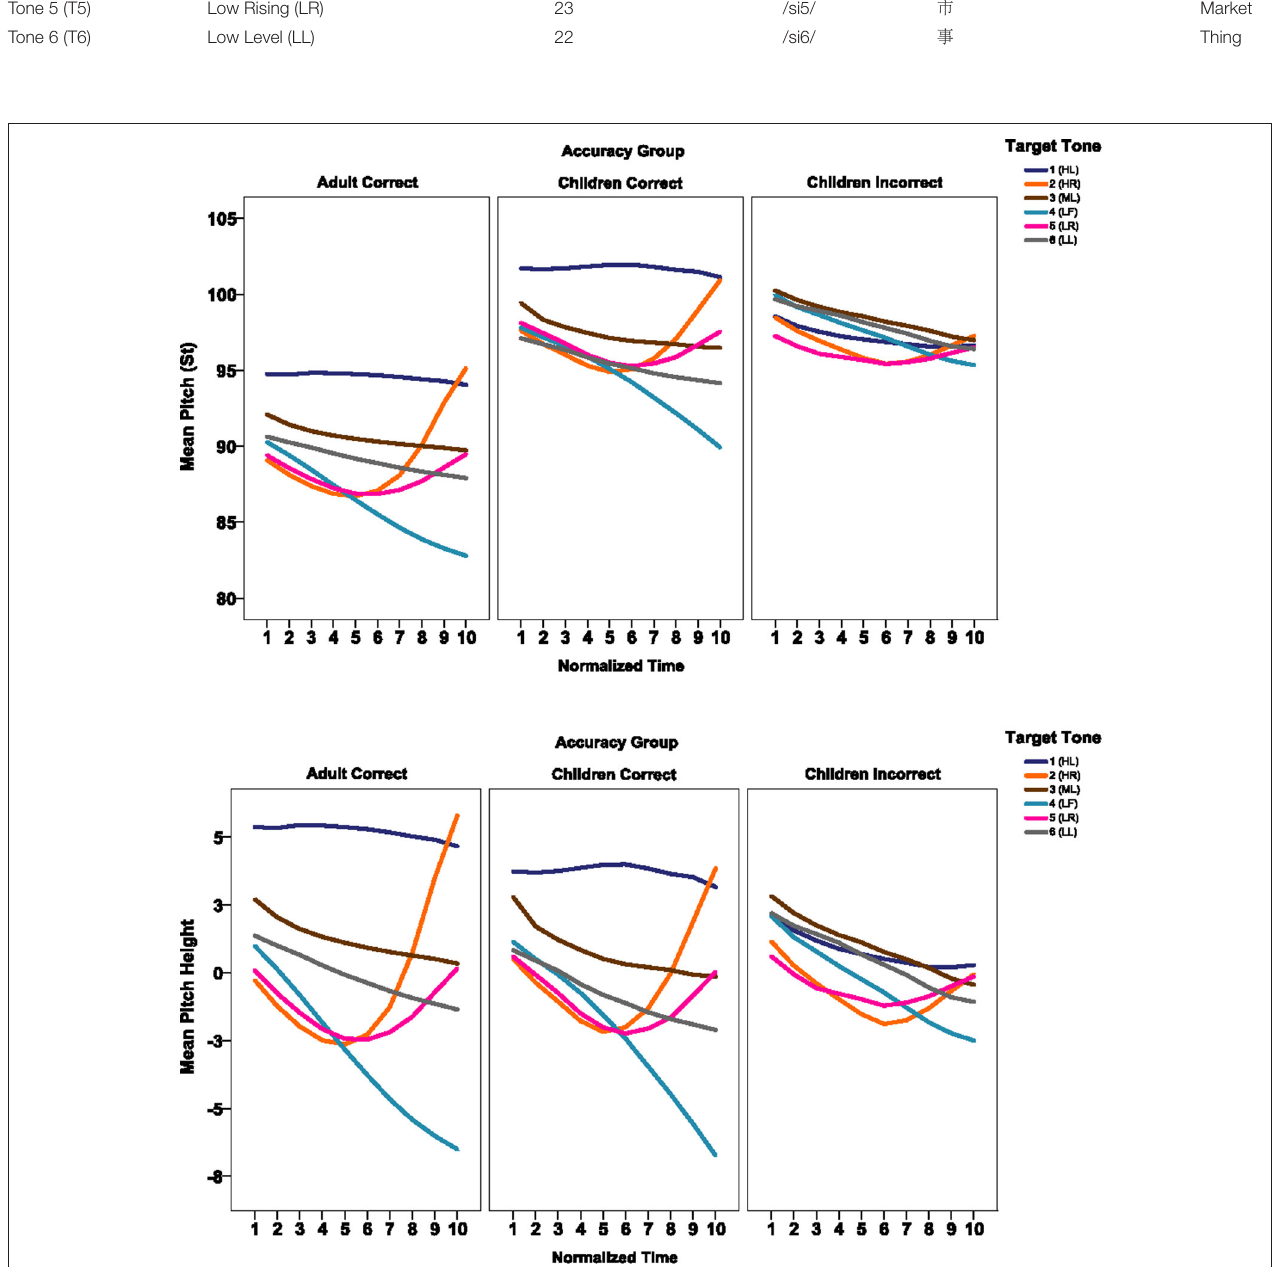
FIGURE 1 | Average pitch contours of the six tones in adults’ correct productions, children’s correct productions and children’s incorrect productions with original pitch (upper panels) and normalized pitch (lower